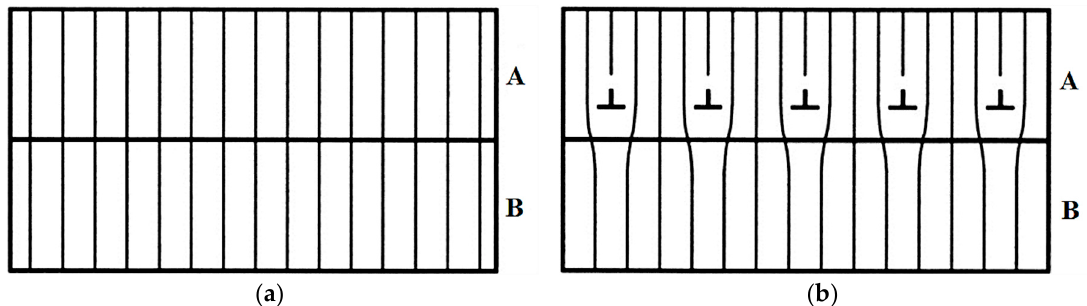
Figure 3. The interface between layers A and B (lattice parameter of the layer B is greater compared to that of the layer A): ( a ) coherent interface, where interplanar distances of the crystal lattices of both layers are equalized perpendicular to the interface; ( b ) incoherent interface, where misfit dislocations (indicated by ⊥ ) compressive stresses at the relaxation of layers are formed [64].